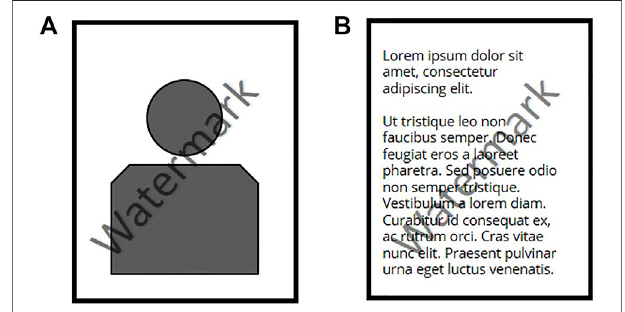
FIGURE 1 | Example of a digital watermark embedded in (A) an image and (B) a text fi le.